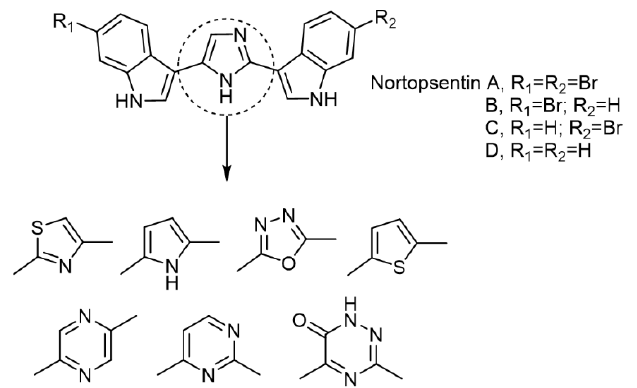
Figure 1. The structure of nortopsentins A–D and their related analogues.